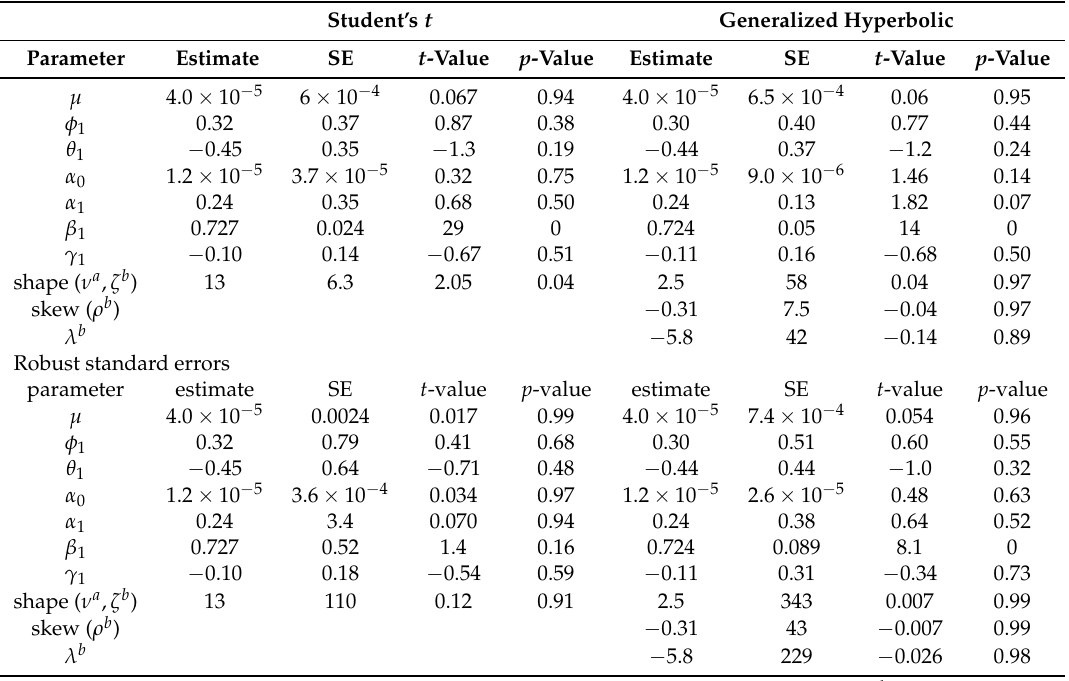
( n ,MSFT ) of t n , k